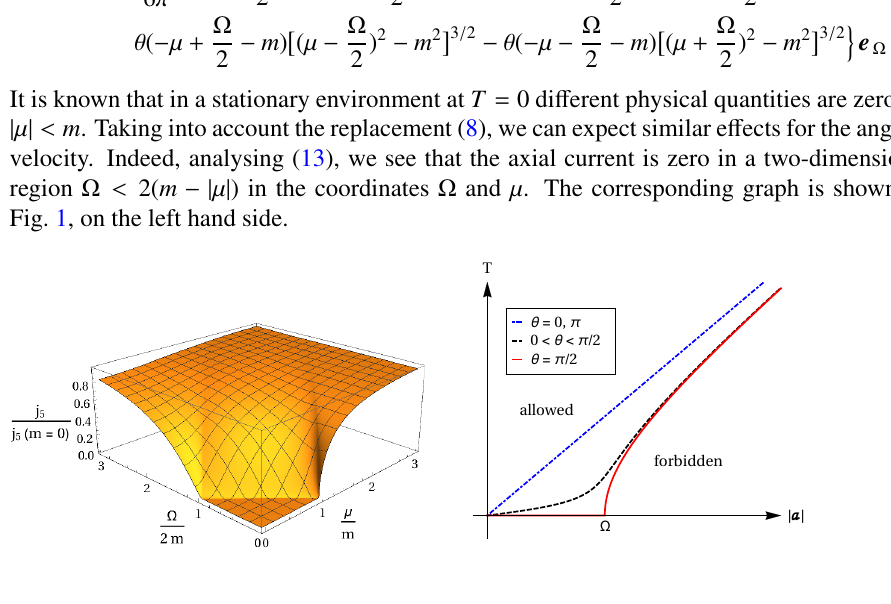
Figure 1. Left : axial current (13), as a function of the chemical potential and angular velocity at zero temperature. Right : curves corresponding to the appearance of instability in axial current on the plane | a | , T . The area below these curves, presumably, is the forbidden region of the values of acceleration and temperature